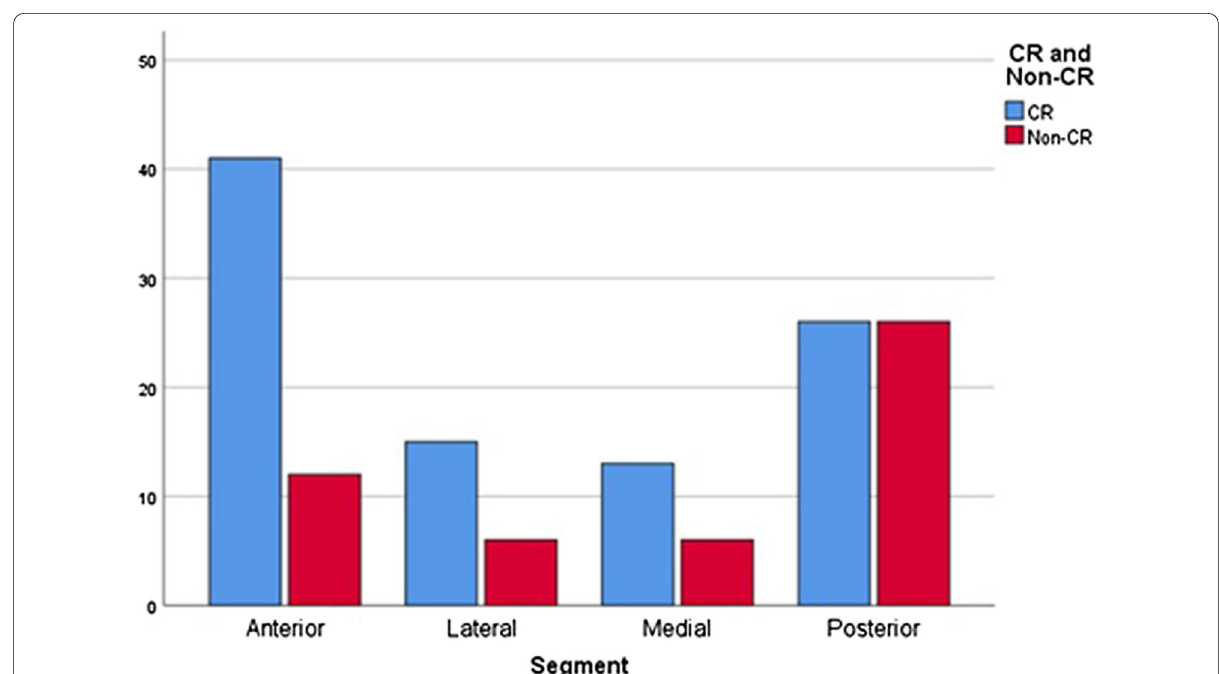
Fig. 4 Bar chart showing the association between the segment of the tumor and CR and non-CR groups, significant difference ( P .03)